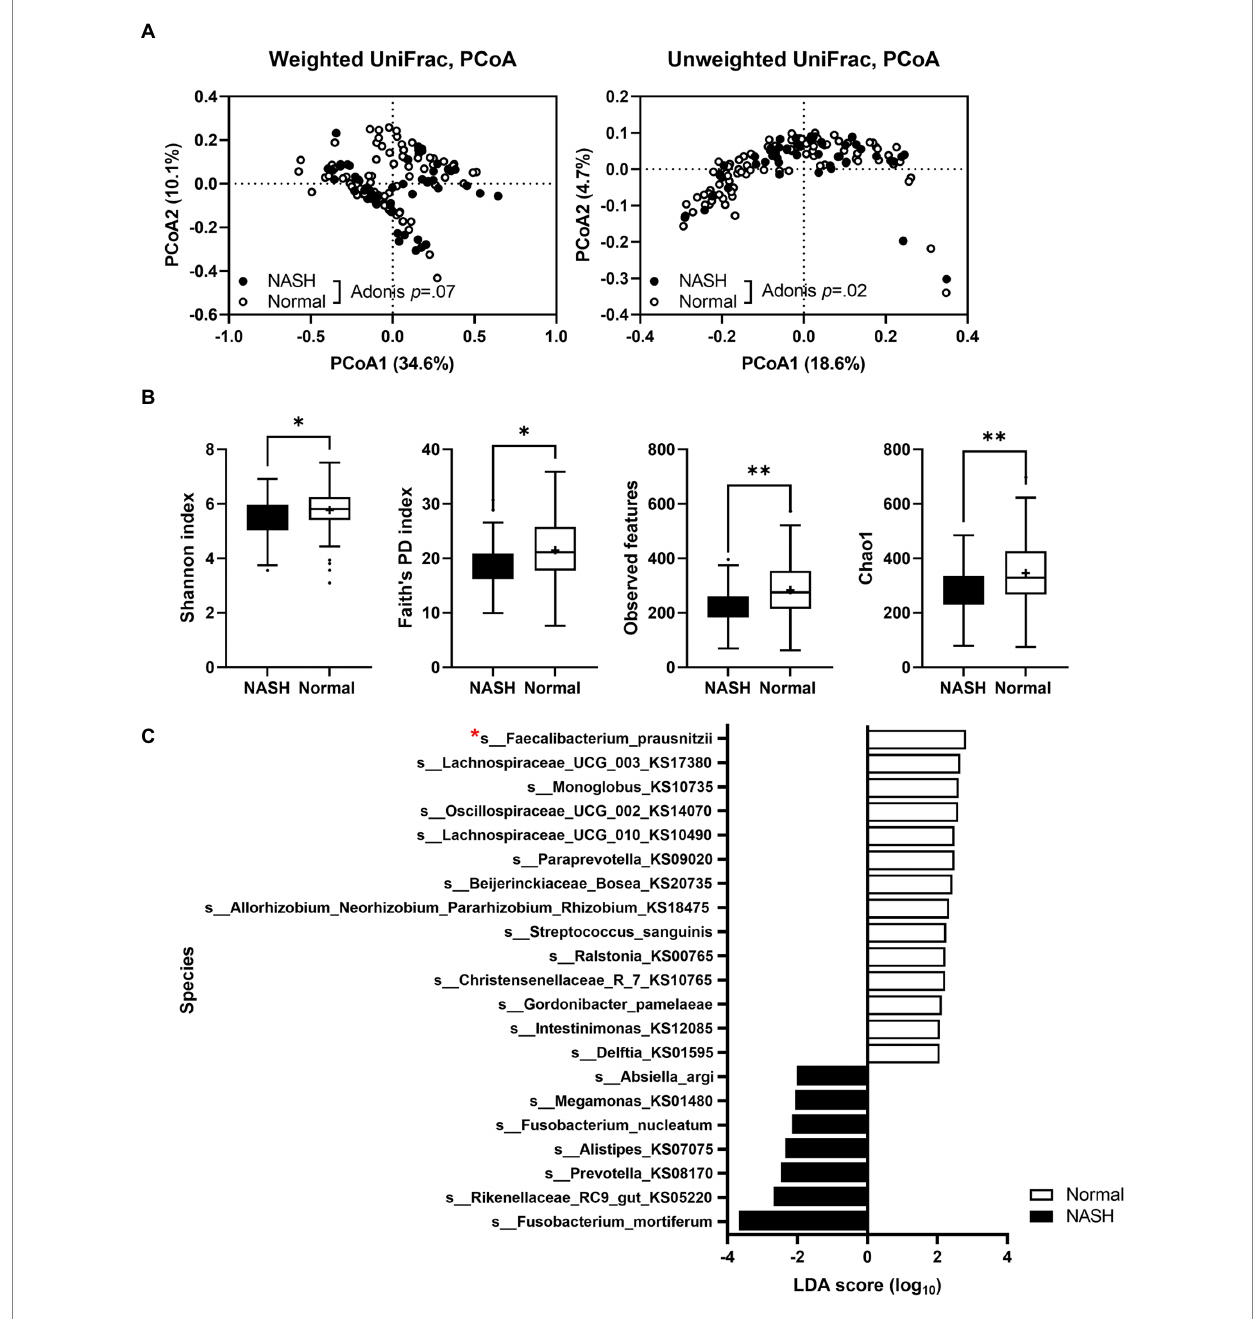
FIGURE 1 A comparison of gut microbiota in patients with NASH ( n = 45) and sex- and age-matched healthy individuals ( n = 99). (A) Principal component analysis plot comparing the microbiota of patients with NASH and healthy individuals using unweighted and weighted UniFrac distances. Adonis tests confirmed significant differences between the two groups. (B) A comparison of the alpha diversity index between fecal samples of patients with NASH and healthy individuals (Mann–Whitney U test; * p ≤ 0.05, ∗∗ p < 0.01). (C) A species-level comparison of the relative abundance of gut microbiota between participants with NASH and healthy individuals. NASH: nonalcoholic